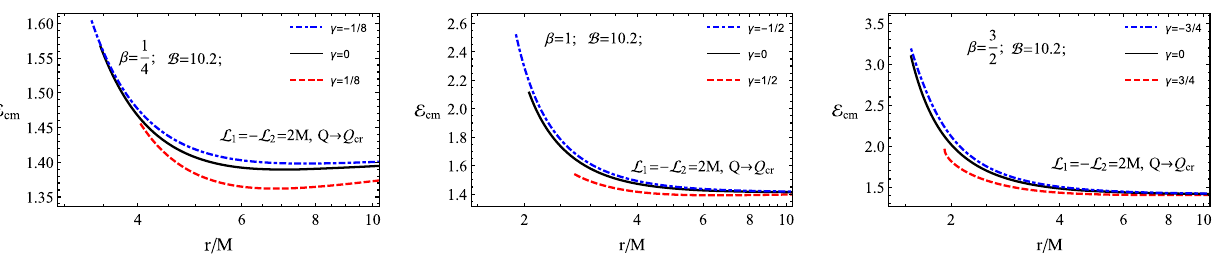
Fig. 12 Dependence of center of mass energy of magnetized and charged particle collision with respect to β at the corresponding values of γ and critical charge